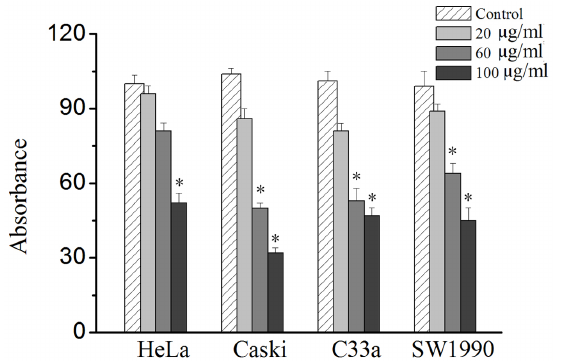
Figure 1. Effects of TCS on cancer cell proliferation. TCS inhibited cell proliferation in a dose-dependent manner. Data represent means 6 SD of three independent experiments (* p , 0.05 compared with control).